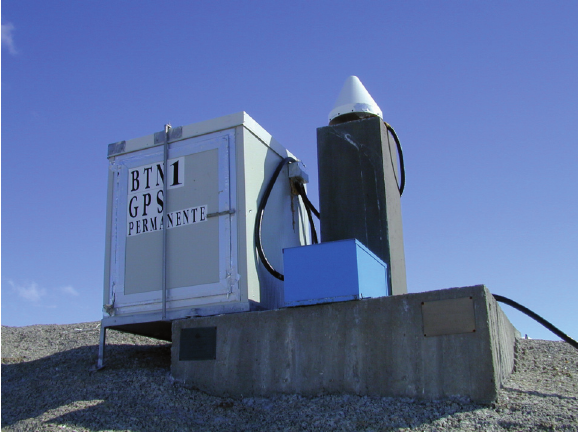
Figure 1. The TNB1 permanent GPS station, the antenna and its cone radome, and the shelter that contains the Ashetch-ZXII re- ceiver and the ancillary